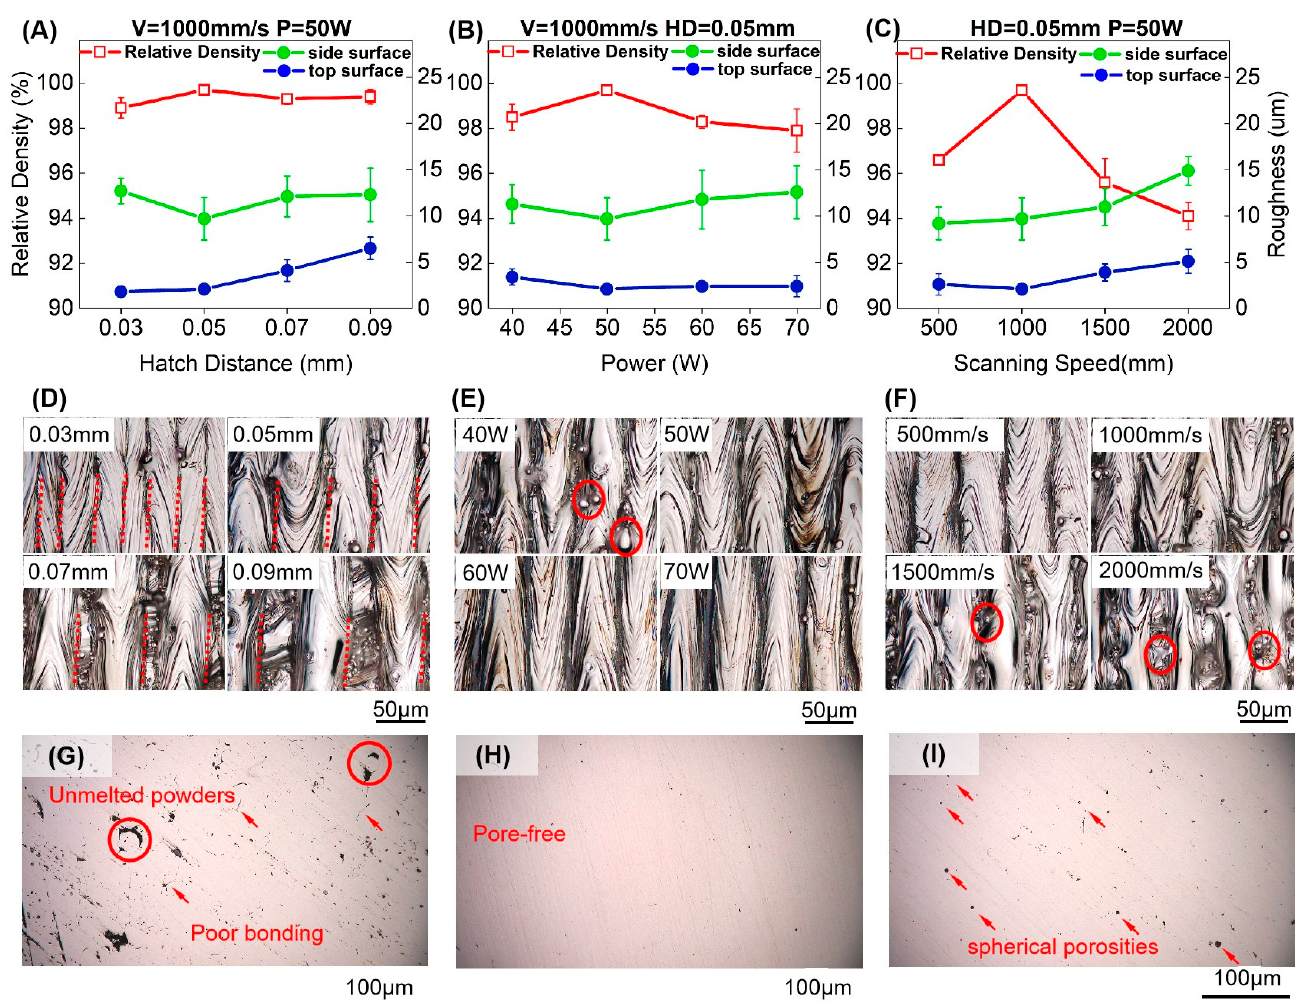
Figure 2. ( A – C ) The relative density and roughness of cubes with different energy density parameters; ( D – F ) Top surface morphology of cubes; ( G – I ) Polished side surface morphology of three process conditions: lack of fusion, dense, overheat- ing.